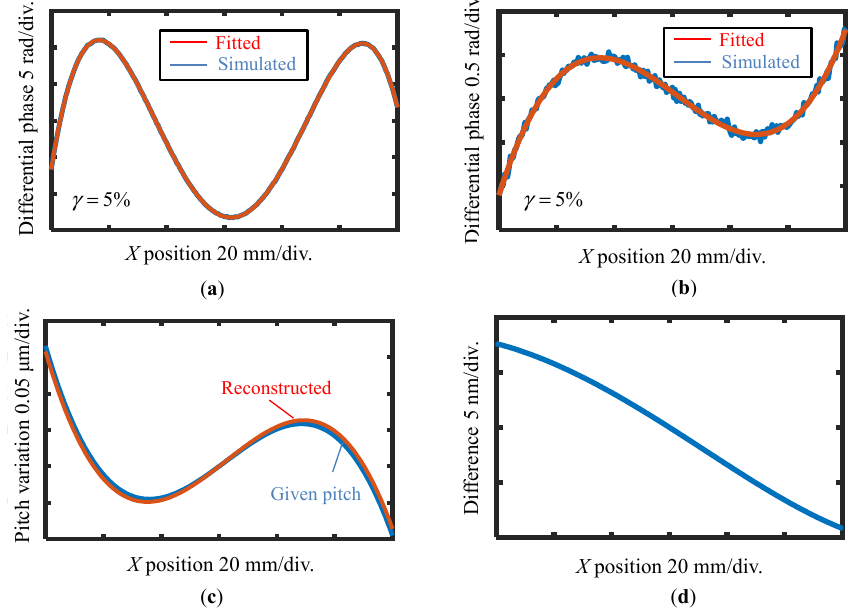
Figure 9. Reconstructed pitch distribution result of case two by using the proposed pseudo-lateral- shearing and reference plane technique: ( a ) Evaluated differential phase outputs and its fitting result before the shift with 5% noise level; ( b ) Evaluated differential phase outputs and its fitting result after the shift with 5% noise level; ( c ) Given pitch in simulation and reconstructed pitch distribution of VLS grating; ( d ) Difference between the simulation and the reconstruction result.